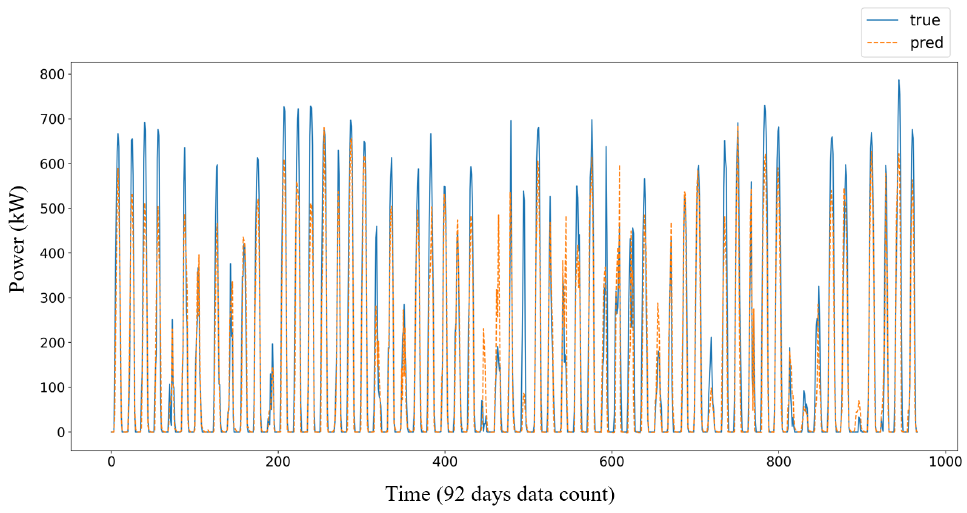
Figure 11. Prediction test used Seosan meterorlogical station irradiance of Danjin SPV power.